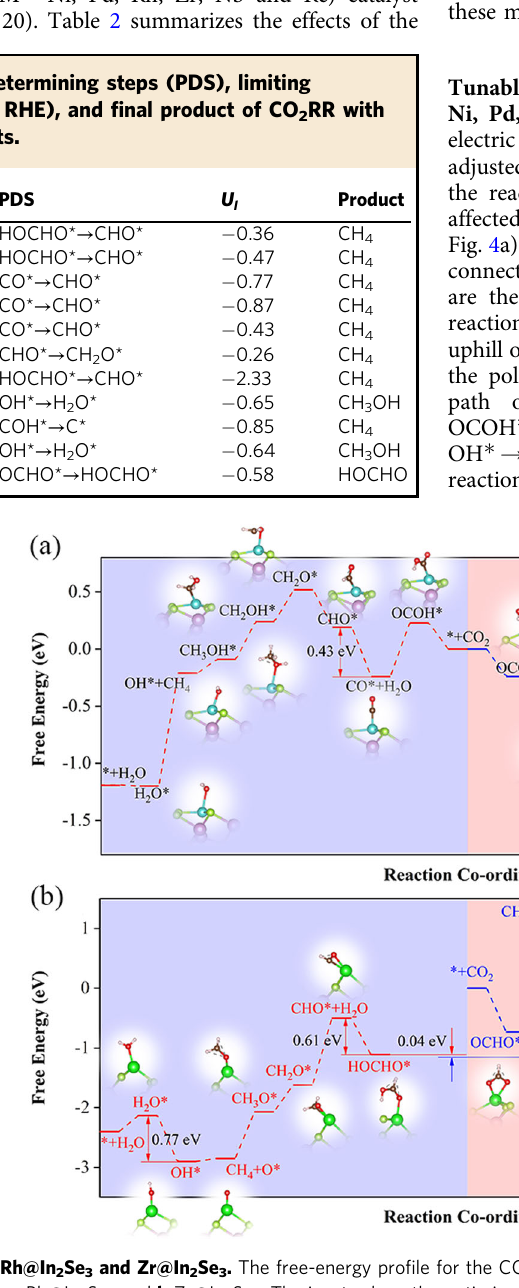
Fig. 4 CO 2 RR paths on Rh@In 2 Se 3 and Zr@In 2 Se 3 . The free-energy pro fi le for the CO 2 electrochemical reduction reactions along the minimum energy path at 0 V (vs. RHE) on a Rh@In 2 Se 3 and b Zr@In 2 Se 3 . The insets show the optimized con fi gurations of the intermediates. The pink (light blue) shaded area indicates the catalytic reaction when the polarization is pointing upwards (downwards). This color scheme is also used in Fig.